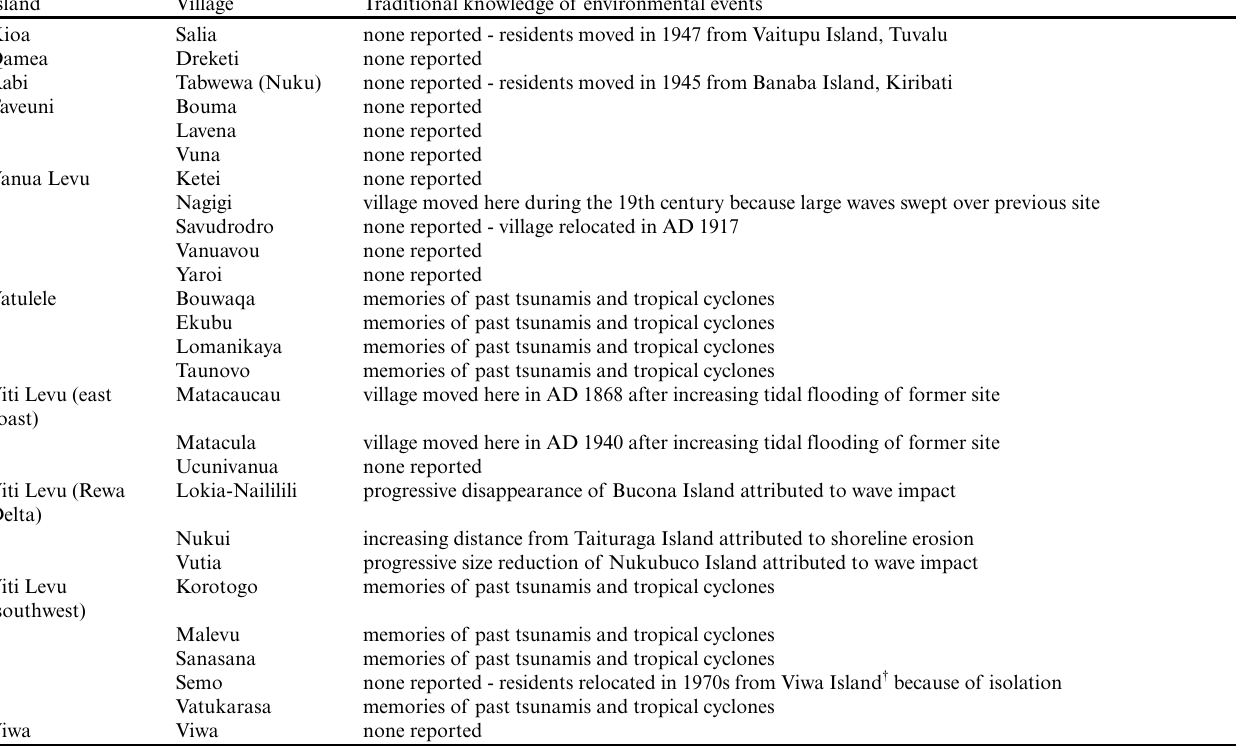
Table 1 . Study sites for village data gathering in Fiji (see Figure 1 for locations). Island Village Traditional knowledge of environmental